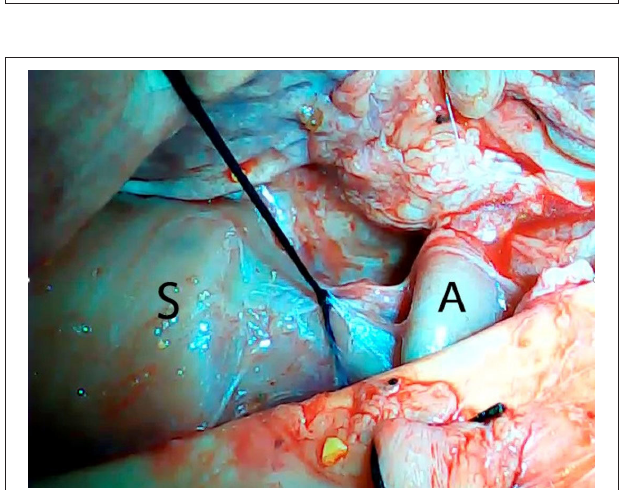
FIGURE 3 | Thoracoscopic silk tie around the mobilized esophagus attaching it to the shaft of the anvil. S, stapler; A, anvil.